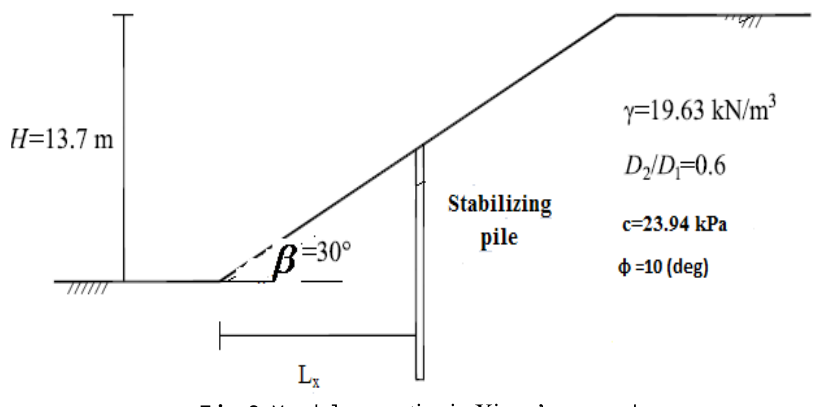
Fig. 6. Model properties in Xinpo’s research Table 1. Comparison of the proposed method with Xinpo’s